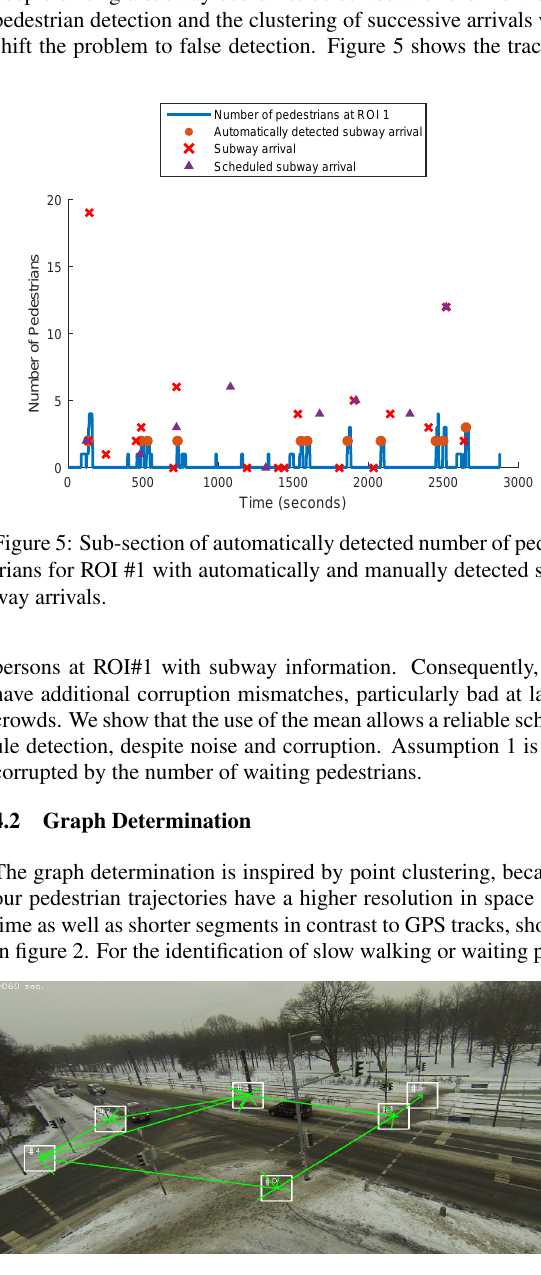
Figure 4: Sub-section of manually collected aggregated number of pedestrians for ROI #1 with automatic and manually detected subway arrivals and schedule.